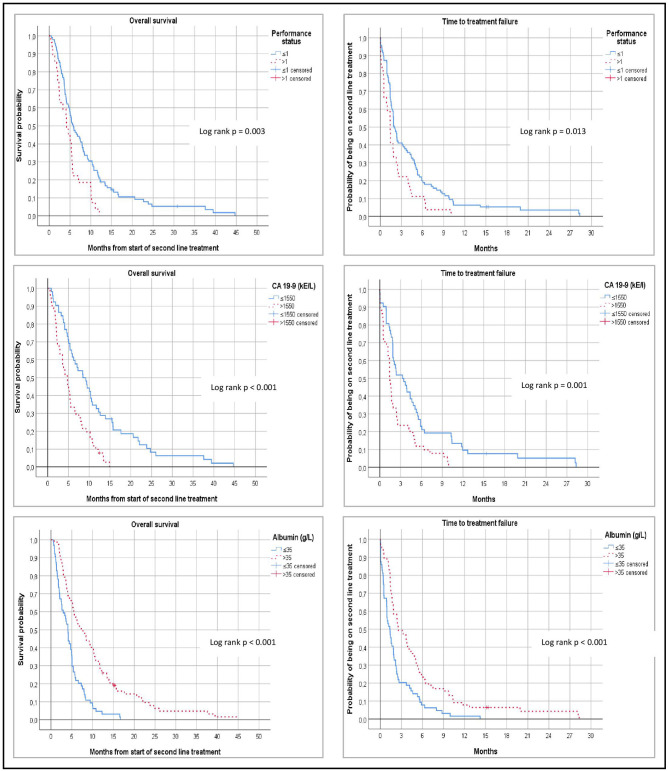
Left: Kaplan Meier estimates of overall survival after start of second line chemotherapy to death or last follow-up (OS2). Right: Time to treatment failure from start of second-line chemotherapy (TTF2). Log rank test were performed to compare subgroups according to baseline ECOG performance status, levels of serum CA-19-9, and levels of plasma albumin.